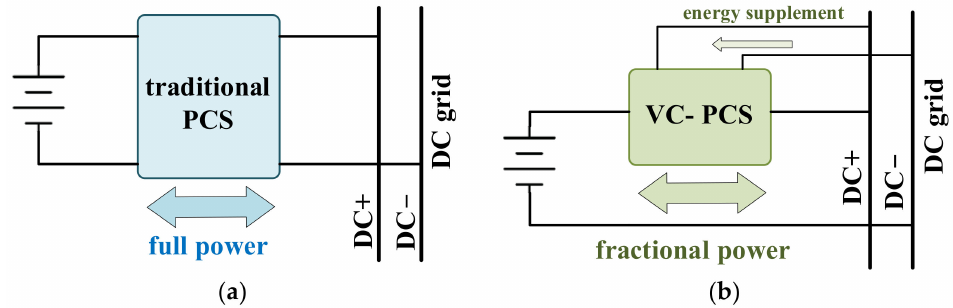
Figure 1. Architectures for interfacing with a battery: ( a ) traditional PCS, and ( b ) VC-PCS. During the charging process, when the battery voltage was higher than the DC grid voltage, the VC-PCS output negative voltage to compensate for the battery voltage increase and supplemented energy loss at the same time. During the discharging process, when the battery voltage was lower than the DC grid voltage, the VC-PCS output positive voltage to compensate for the battery voltage decrease and supplemented energy loss at the same time. In other words, the VC-PCS could charge and discharge the battery whether the battery voltage was higher or lower than the DC grid